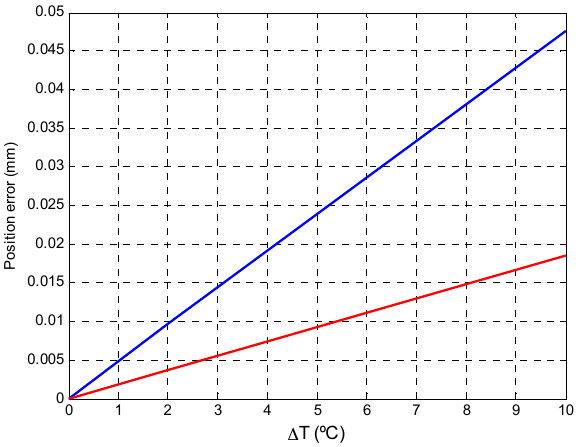
Figure 10. Average and maximum error in calculating the position of the point of incidence caused by large temperature differences.